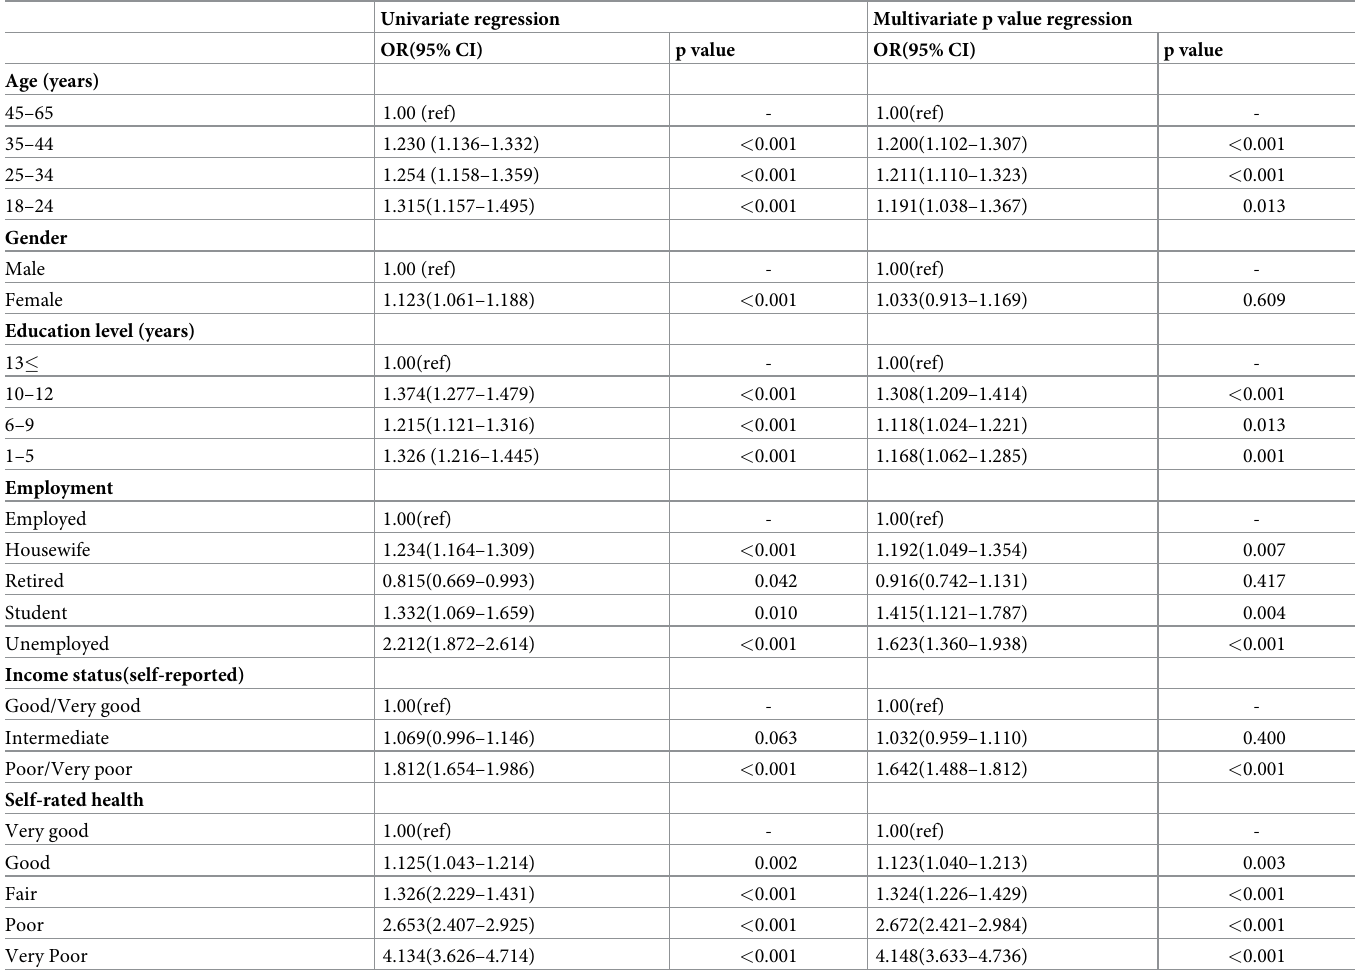
Table 5. Relationship between Oxford happiness scores (without item 28), health status and demographic